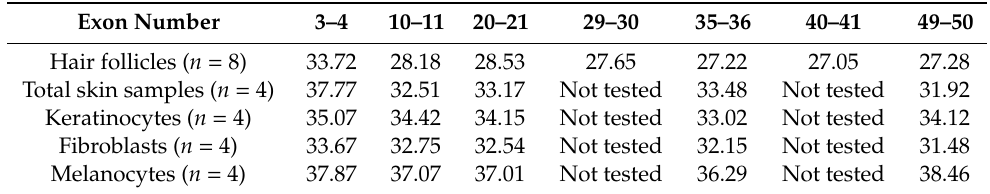
Table 1. Average Ct of ABCA4 gene expression in hair follicles, skin samples, keratinocytes, dermal fibroblasts and melanocytes.